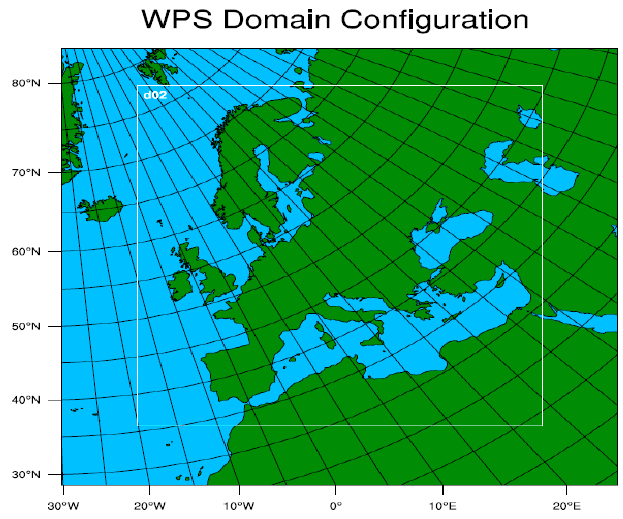
Figure 1. WRF multinesting domain configuration